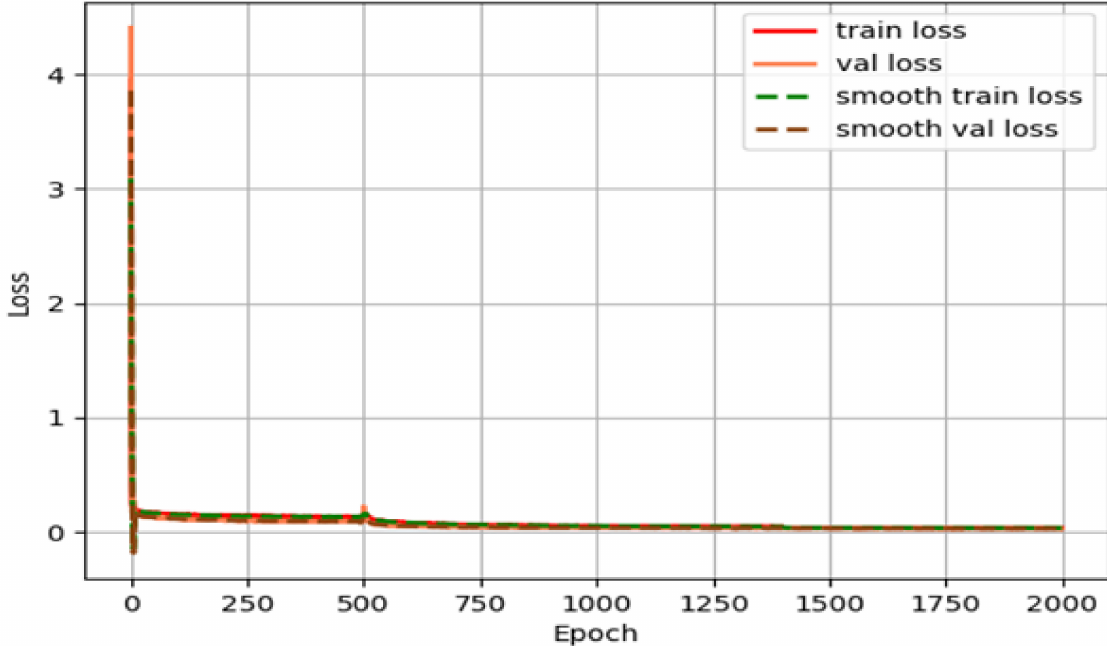
Figure 9. The curve of the loss value changing with the number of